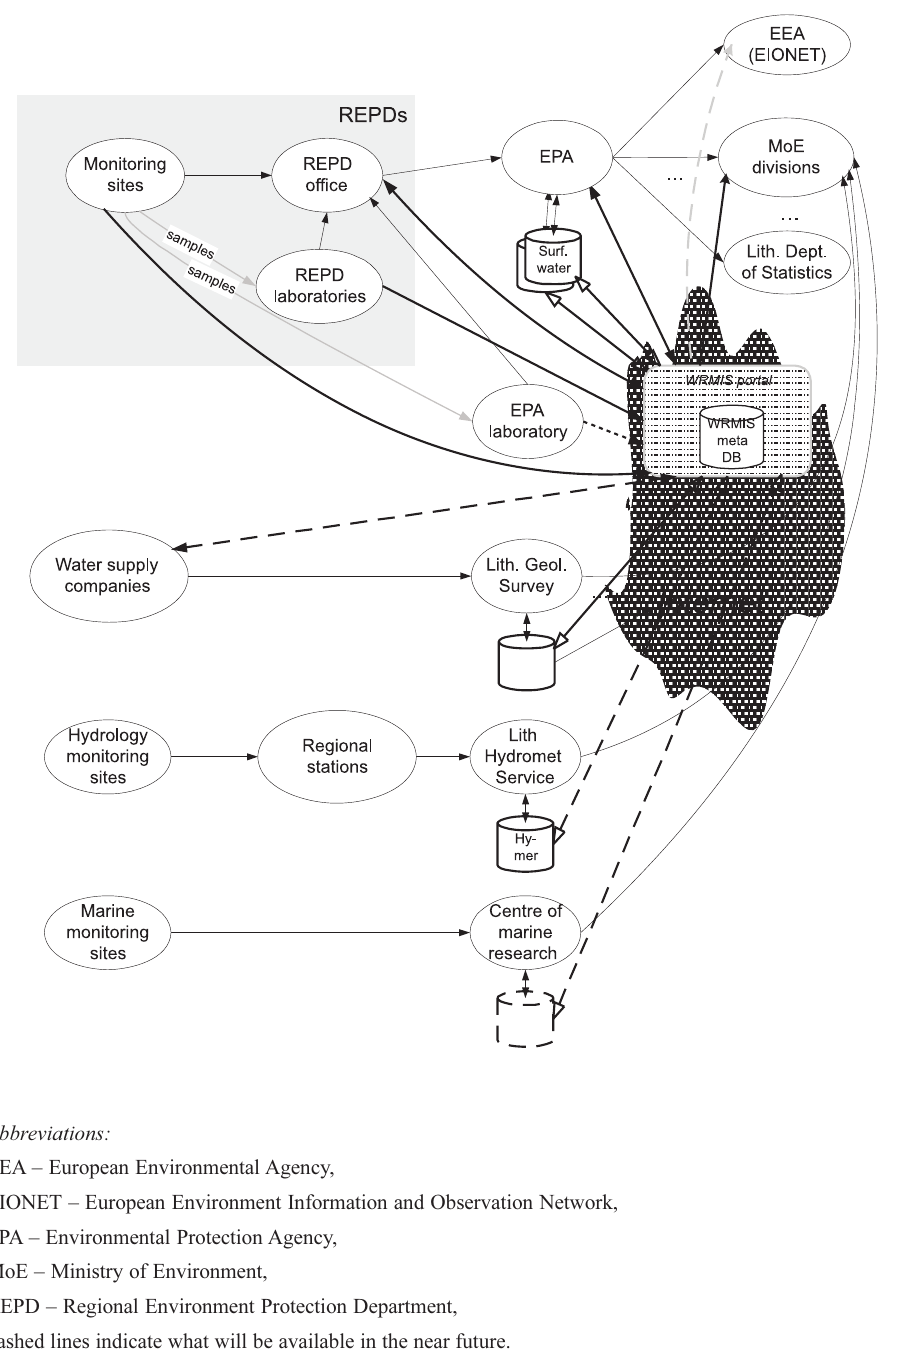
Fig. 2. Environmental Water sector data flows enhanced by the